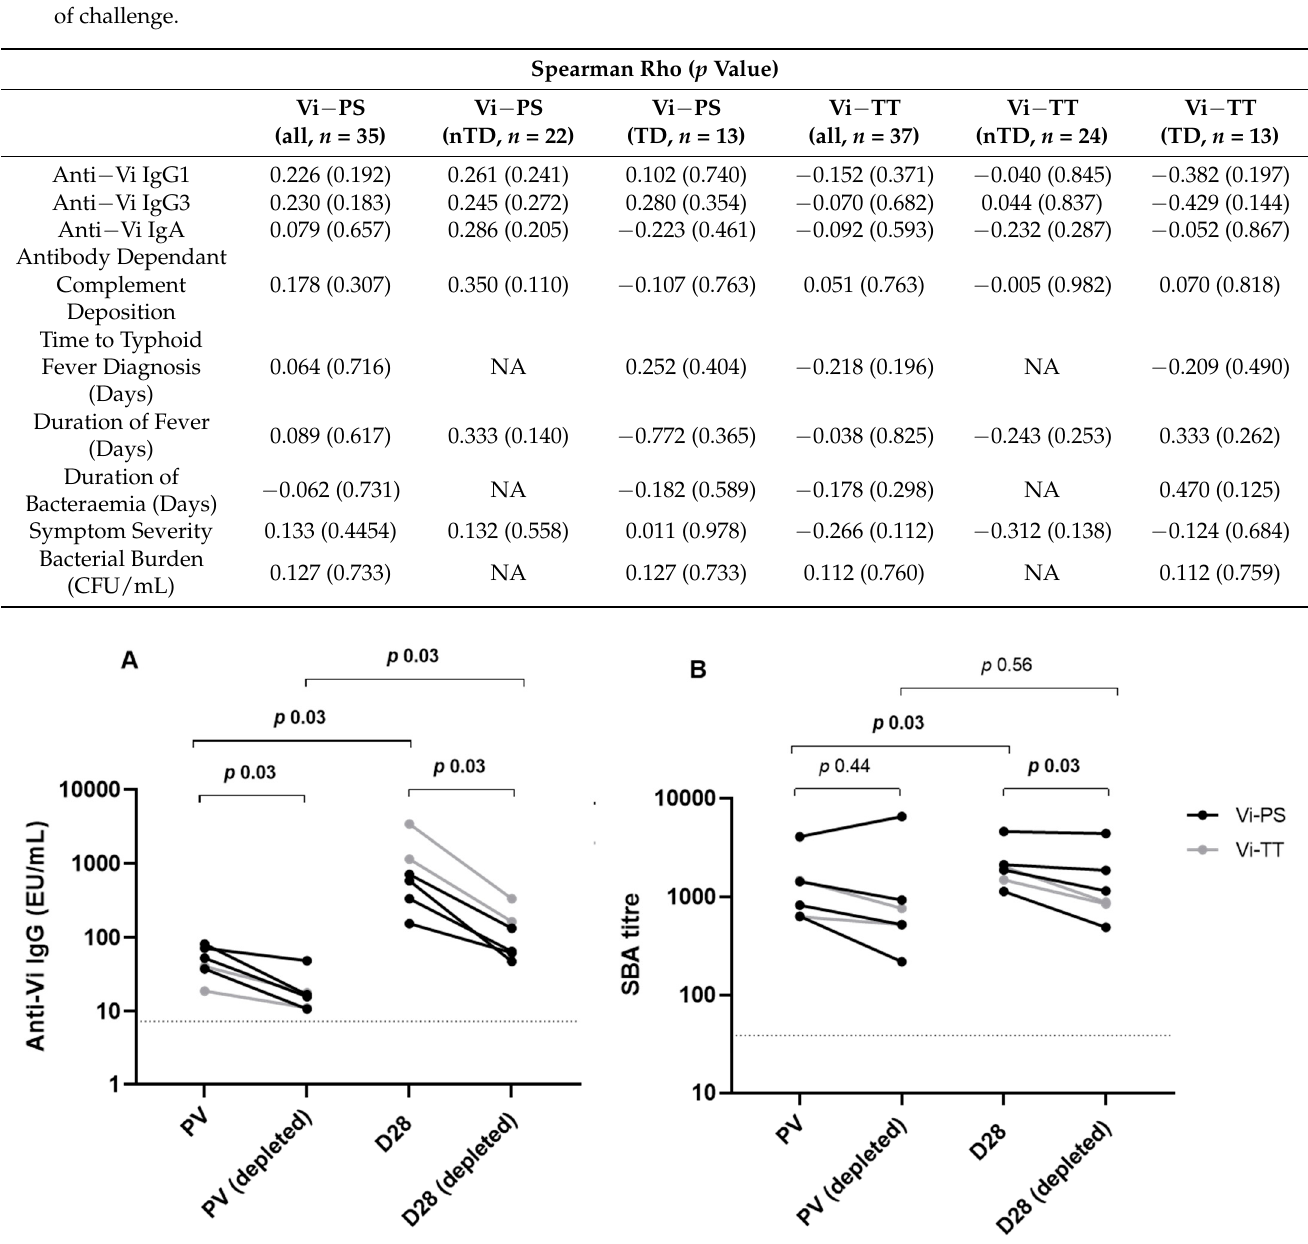
Figure 3. ( A ) Anti-Vi IgG titre determined by ELISA, pre and post Vi antibody depletion, in a subset of Vi-PS and Vi-TT vaccinated individuals. Dotted line marks the limit of detection, 7.4 EU/mL. ( B ) Corresponding SBA titres from pre and post depleted serum. Dotted line marks the limit of detection, 39. ( n = 6).